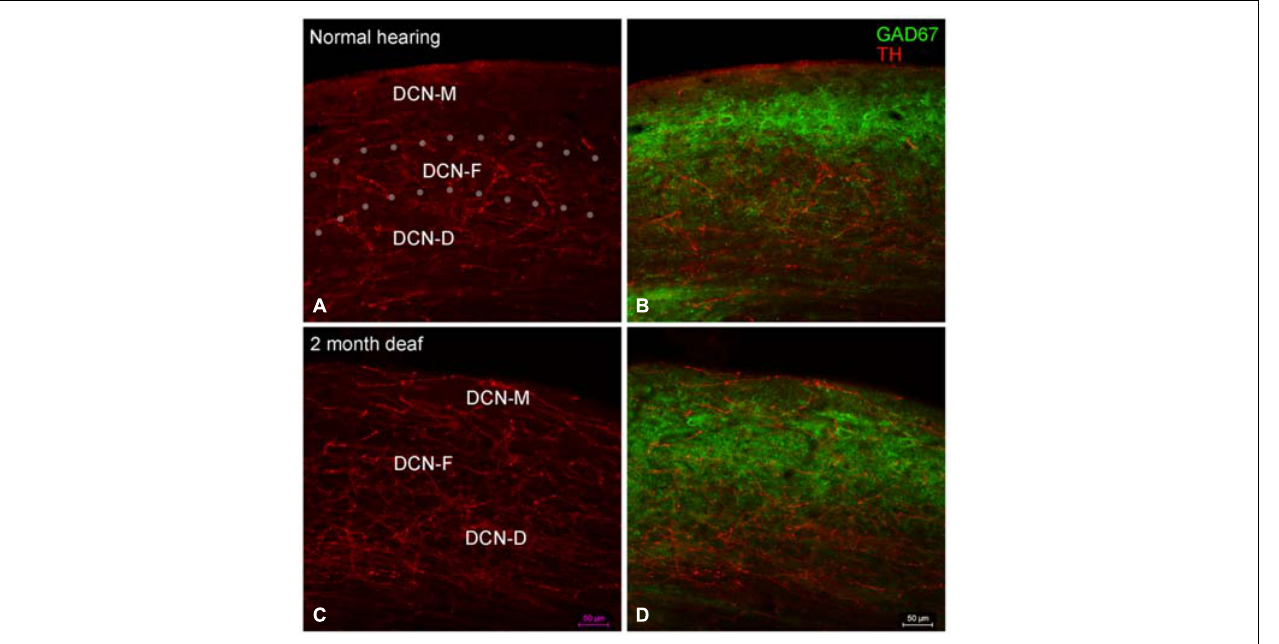
FIGURE 6 | In the DCN the GAD67 labeling (green) is distinct from TH (red) with sparse labeling for TH fibers in DCN-M (A,C) and GAD67 (B,D) primarily localized to terminals with distinct labeling in ventral DCN-M and DCN-F. Following deafness GAD67 labeling increases in DCN-M and